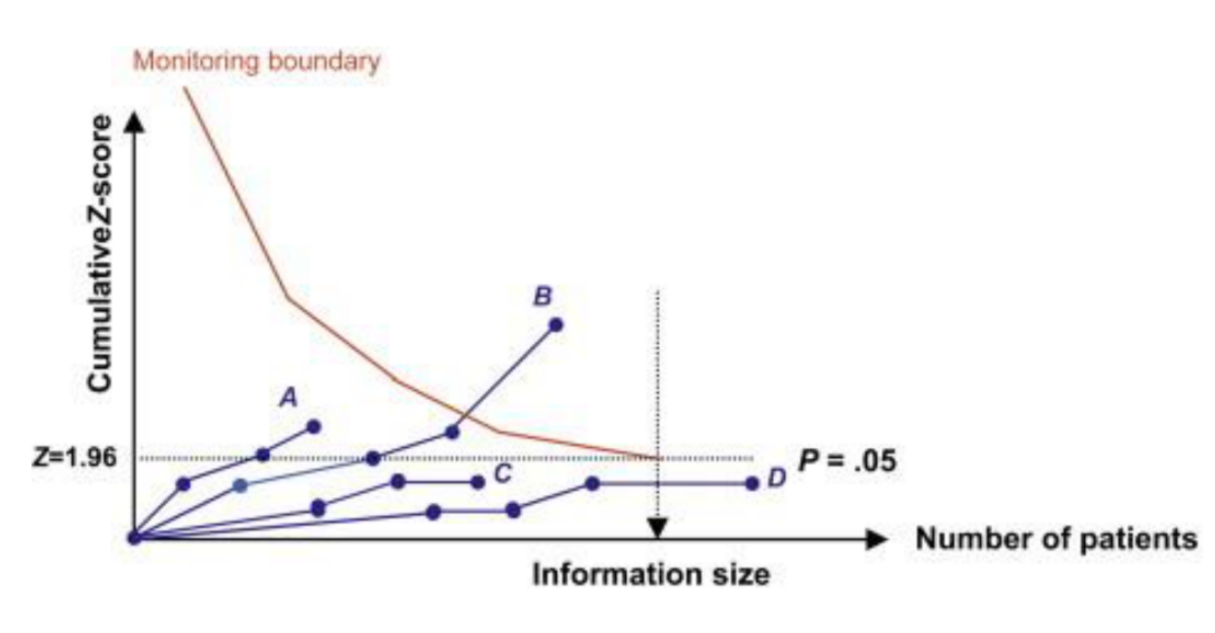
Figure 2. Trial sequential